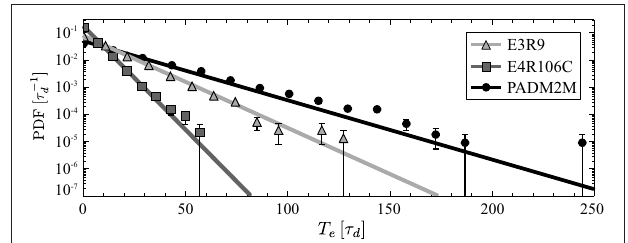
FIGURE 9 | Probability density functions of the escape time T e obtained from 10 4 numerical realizations of the stochastic model for the reversing dynamo models E3R9 and E4R106C, and for the palaeomagnetic model PADM2M. The solid lines are the exponential PDFs